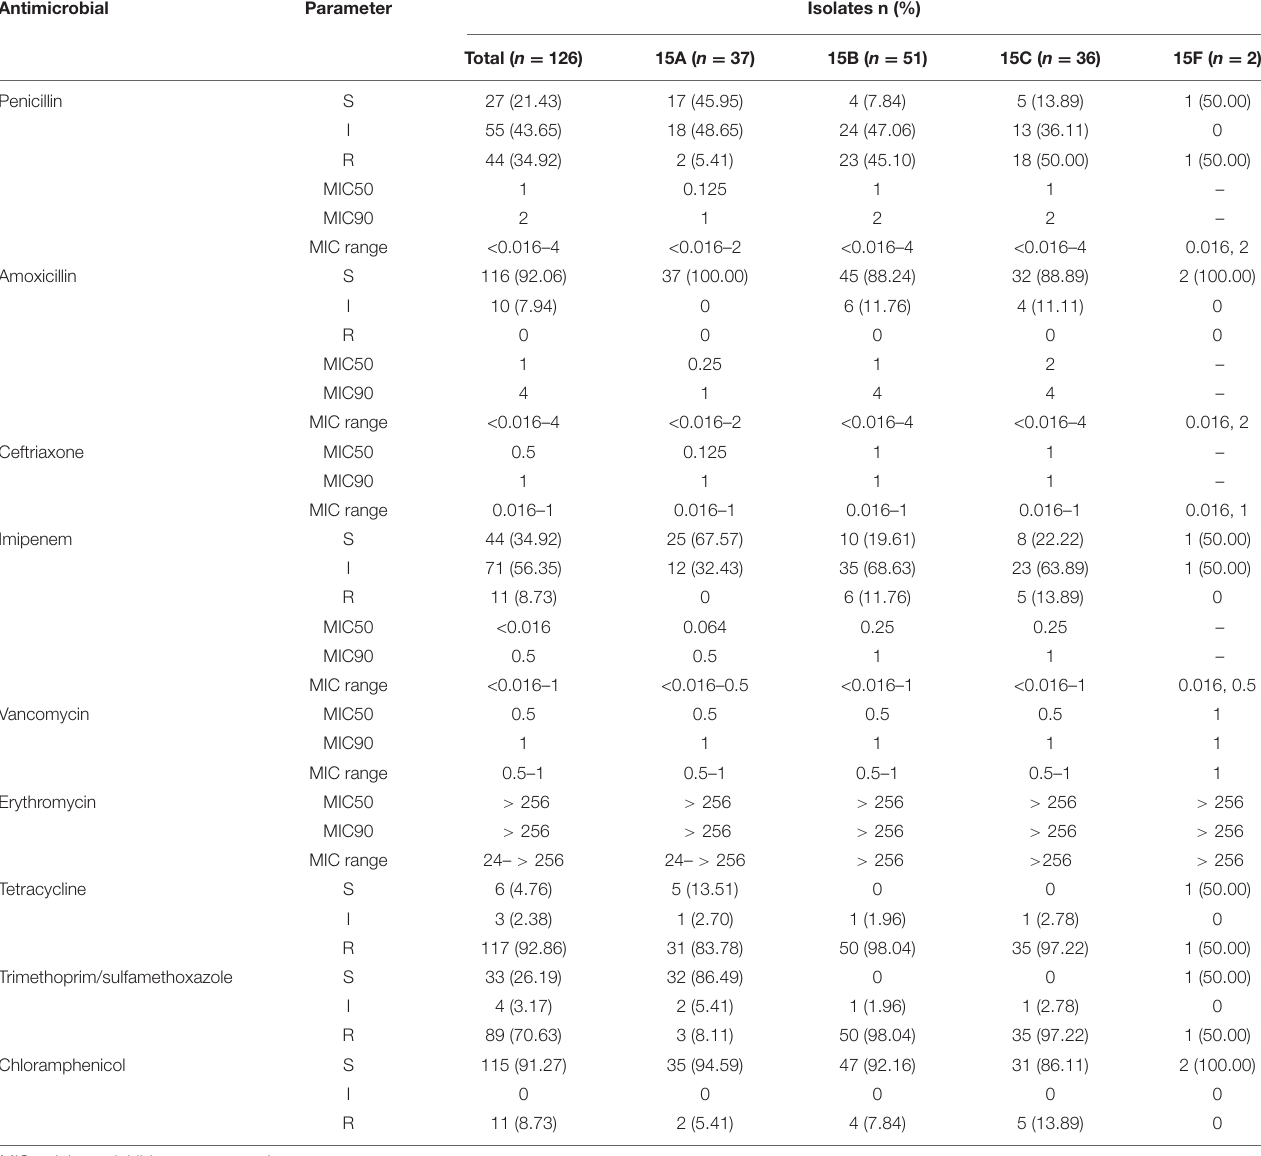
TABLE 2 | Antimicrobial susceptibility pattern of the 126 serogroup 15 Streptococcus pneumoniae strains.